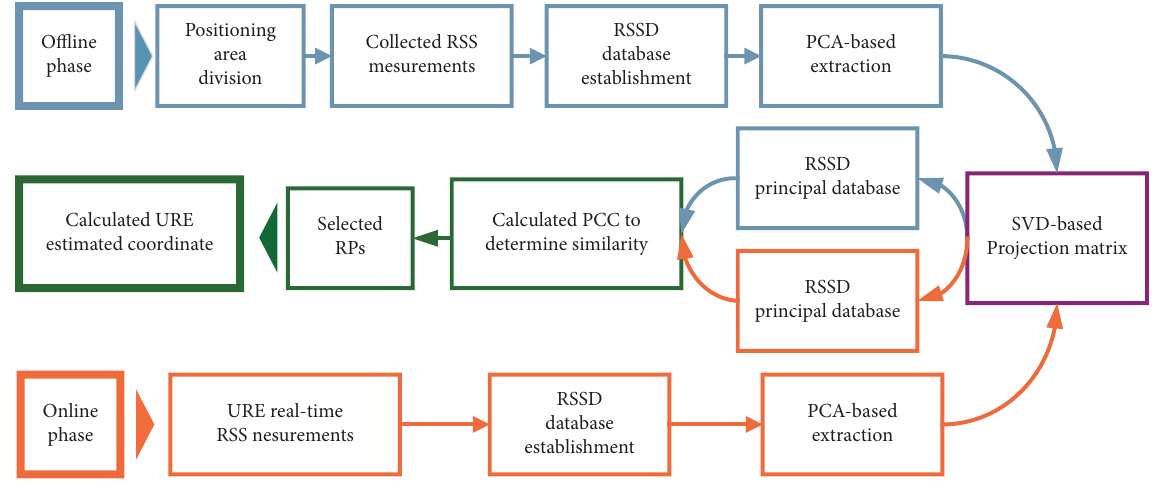
Figure 2: Te fowchart of the proposed RSSD-PCA-PCC algorithm.